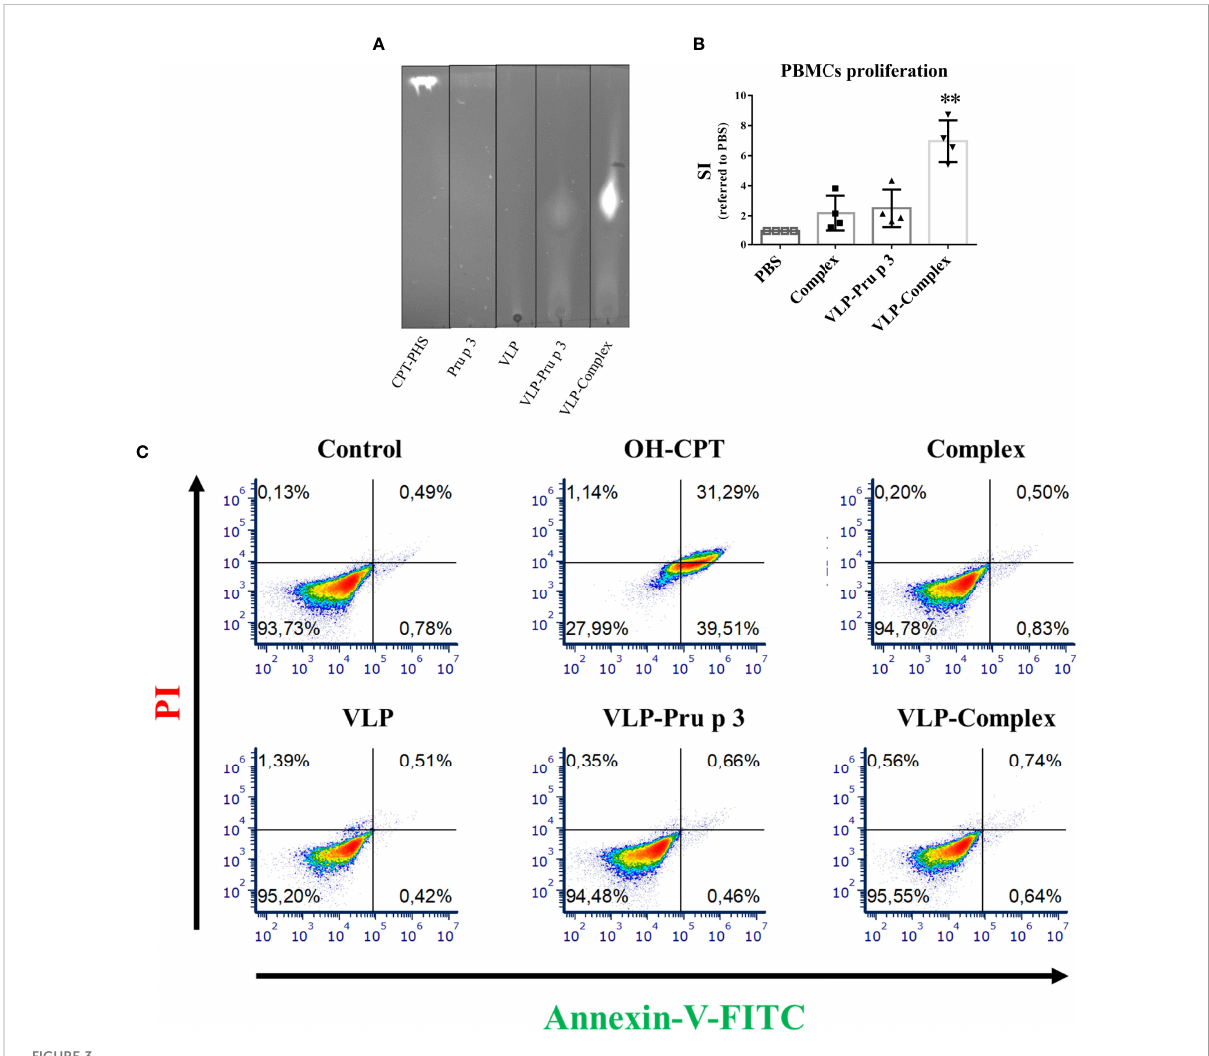
FIGURE 3 In vitro effects of VLP-Complex over immune cells. (A) Assessment of VLP-Complex formation by TLC. Lipidic fraction was detected by emission under UV light, due to CPT activity. (B) Proliferation assay of human PBMCs from healthy volunteers (n = 4), stimulated with Complex, VLP-Pru p 3 or VLP-Complex. After 5 days, cell numbers were determined by fl ow cytometry and SI was calculated as described in Methods. Data are presented as mean (SD, Kruskal-Wallis test with Dunn ’ s correction for multiple comparisons). **P < 0.01. (C) Effects of VLP, VLP-Pru p 3 and VLP-Complex on monocyte apoptosis by Annexin V-PI detection. To quantify the toxicity of the production, they were incubated with THP1 (cells of monocyte origin) for 16 hours. After that, annexin V or PI were added to quantify cell mortality. Four technical replicates were performed for each stimulus. Representative results are